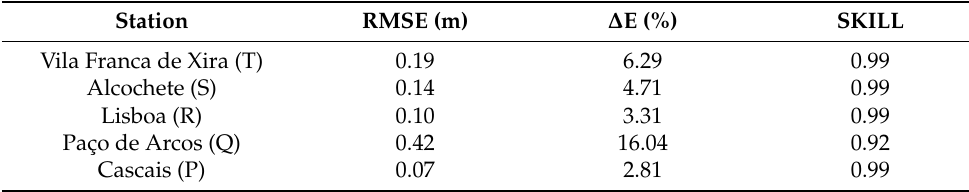
Table 2. Tidal model performance resulting from the calibration. Station RMSE (m) ∆ E (%) SKILL Vila Franca de Xira (T)